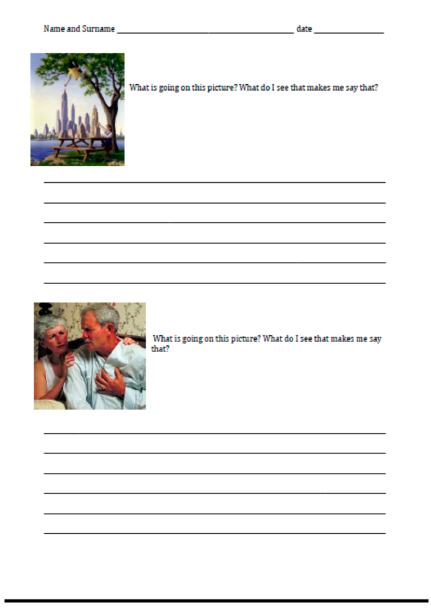
Figure 2. Write assessment of VTS activities.